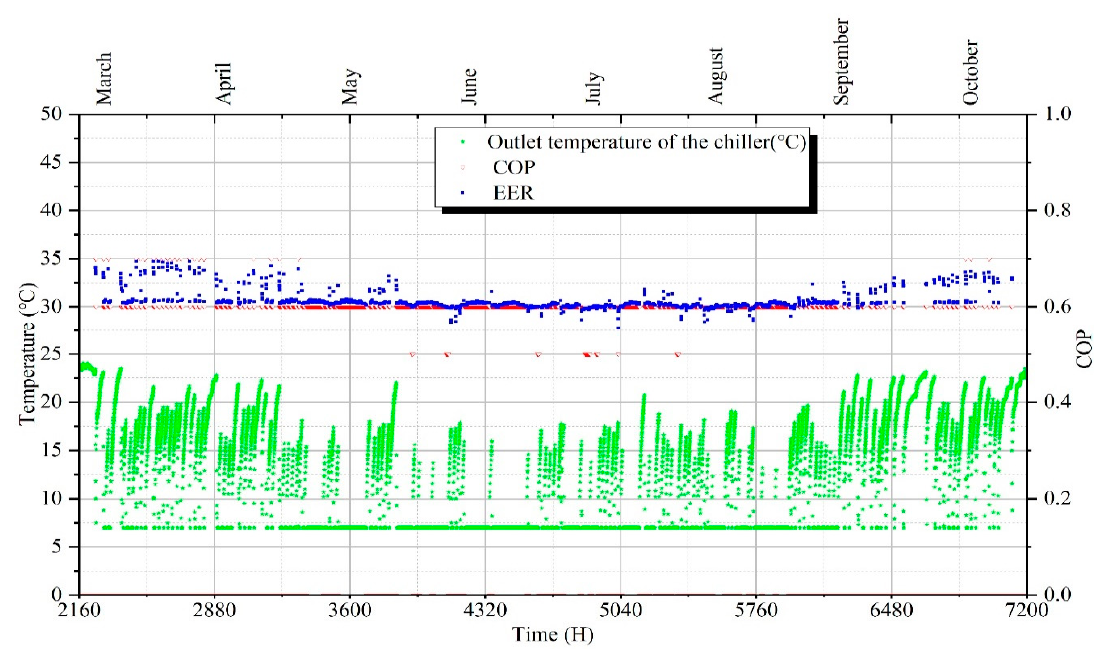
Figure 16. COP, energy efficiency ratio (EER) and outlet temperature of the chiller during cooling mode.